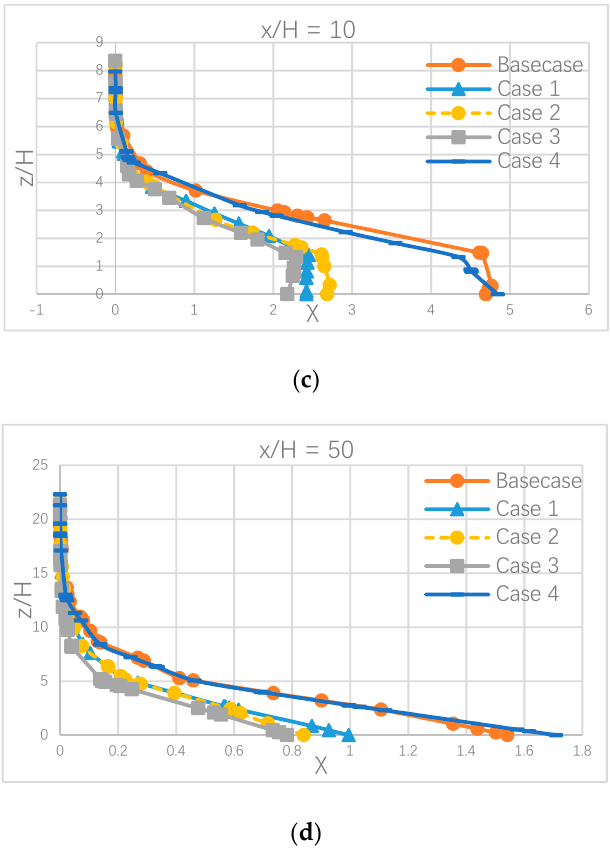
Figure 13. Vertical distribution of CO normalized concentration at different locations (H = 9 m). ( a ) x/H = 0: on the highway; ( b )( c ) x/H = 5, 10: near the highway; ( d ) x/H = 50: far downstream.